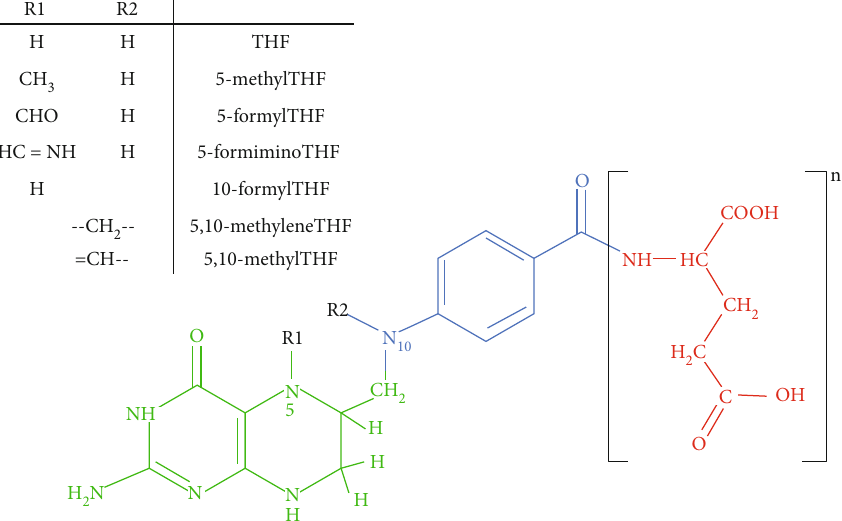
Figure 2: Folates are tripartite molecules, which consist of a pteridine ring (green), a para-aminobenzoate (blue), and a glutamate tail (red). A fully reduced tetrahydrofolate (THF) is present in these chemical structures. Figure adapted from Taylor and May